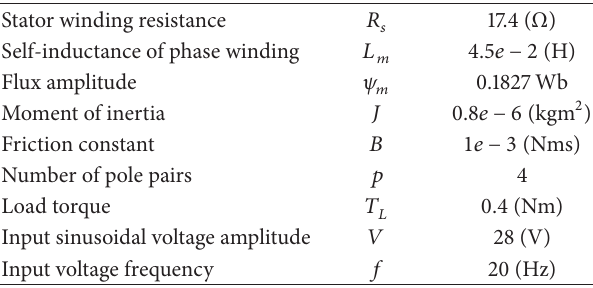
Table 1: Parameters of five-phase PMSM used for simulation. Stator winding resistance